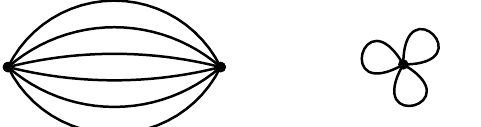
Figure 3. The two Feynman diagrams (the fundamental melon on the left, and the triple-tadpole, or trefoil, on the right) starting from which all the vacuum melon-tadpole diagrams can be built. The melon is based on the wheel vertices and the triple-tadpole is based on any of the interactions I i (for explicit examples of the corresponding colored graphs in rank 5, see (cid:12)gure